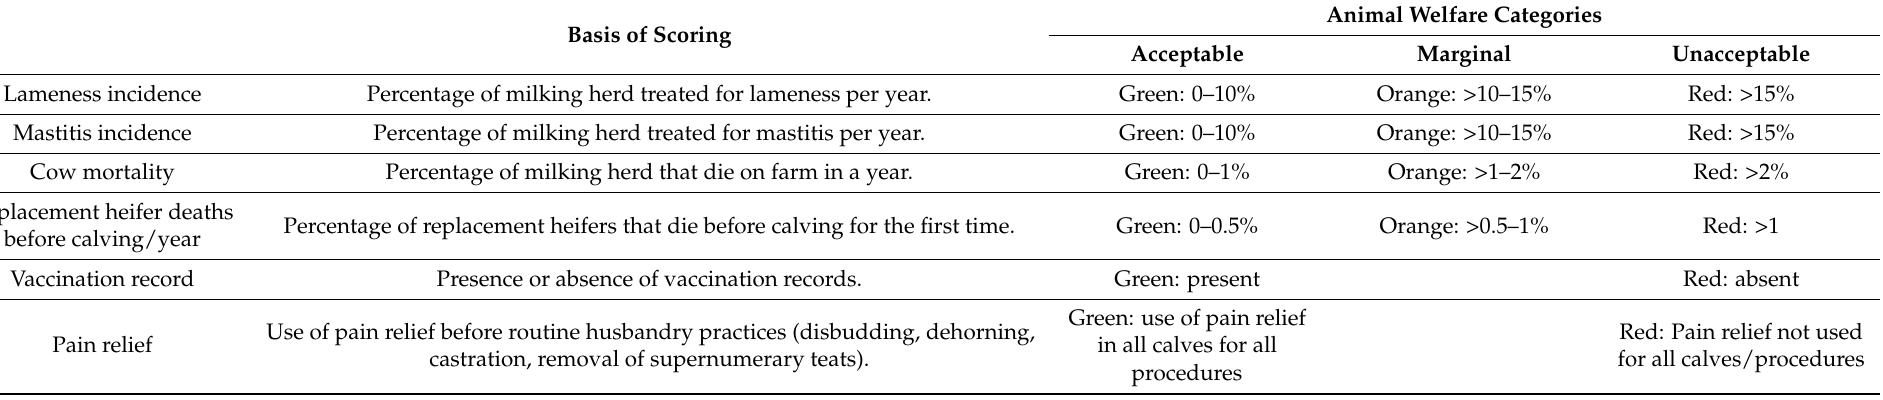
Table 3. Method of assessment for record-based assessment measures from the pasture-based dairy cattle welfare assessment protocol, with the categorization based on author-determined thresholds.